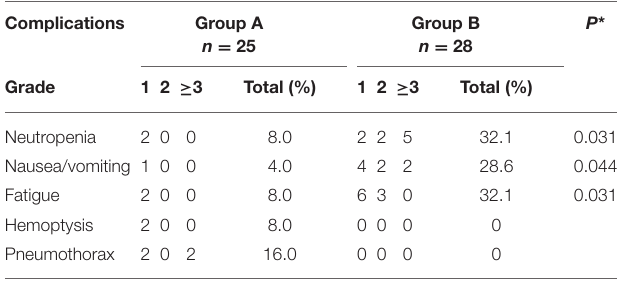
TABLE 2 | Disease control in two groups.